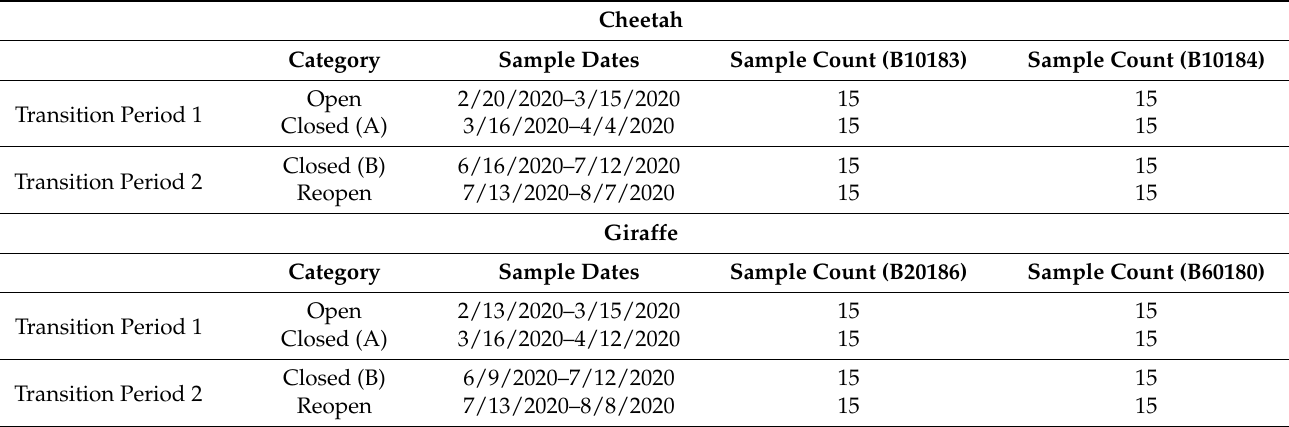
Table 1. List of different treatment periods, their corresponding dates and the number of fecal samples collected within the time. Samples analyzed within Open and Closed (A) are part of Transition Period 1 while samples analyzed in Closed (B) and Reopen are part of Transition Period